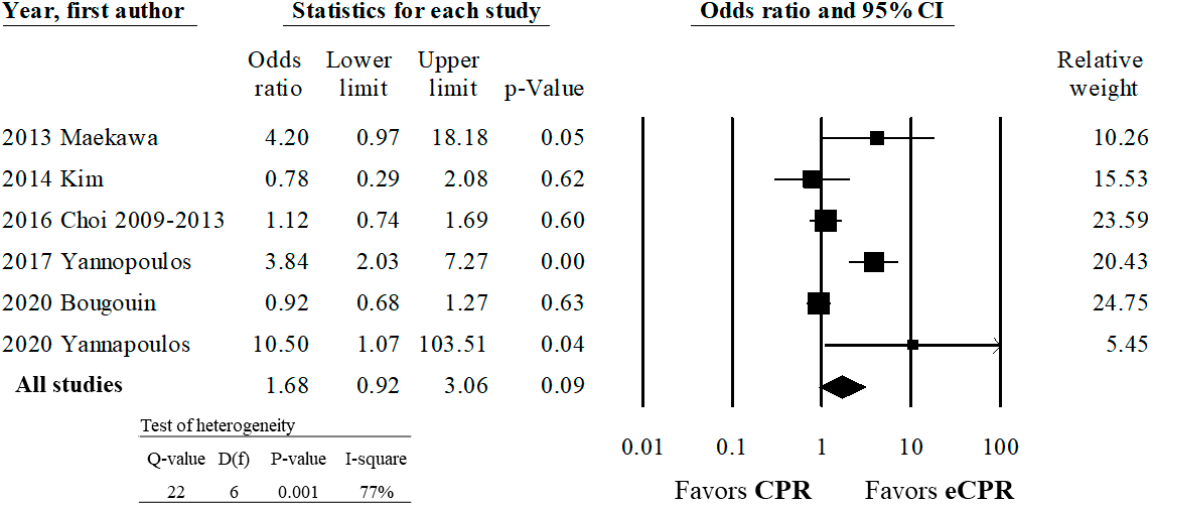
Figure 3. Association of ECPR and conventional CPR with survival to hospital discharge among patients with OHCA.